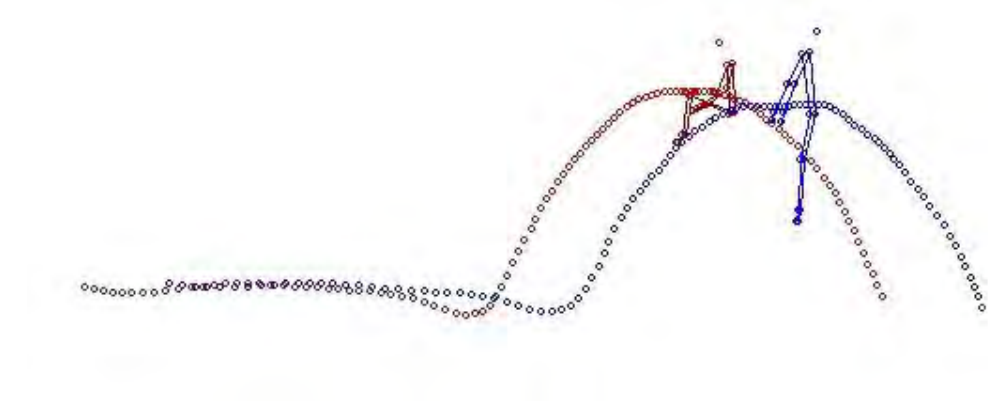
Fig.5. Phase of main movements at acrobats’ passing to second somersault (grouped back double somersault after rondat and arched back double somersault after rondat – back turnover. Key element of sport technique – MP “grouping” (tested A, variant 1, time 1. 266 sec.) and MP “arching” (tested B, variant 2, time 1. 183 sec.).